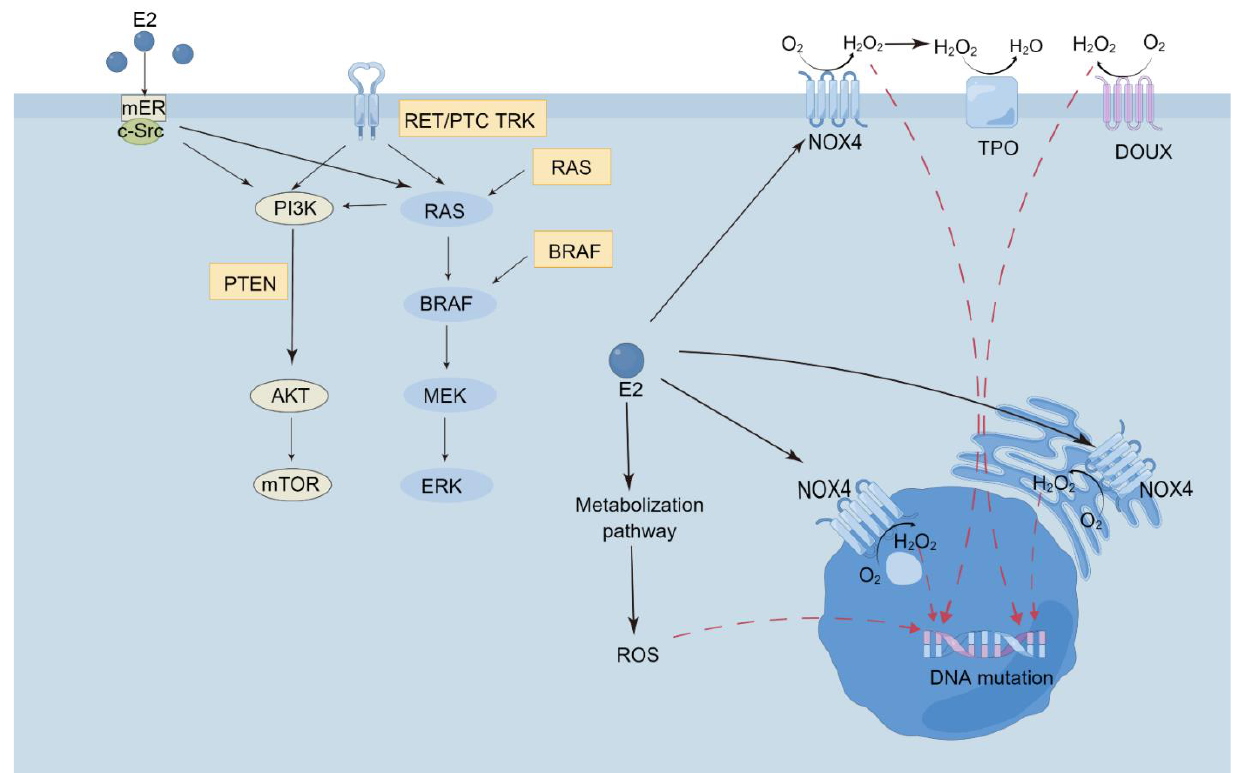
Figure 3. Estrogen non-genomic signaling pathway and estrogen-induced ROS generation in thyrocyte. The non-genomic signaling of E2 occurs via the membrane-bound receptor mER, which stimulates activation of the MAP kinase and the PI3 kinase signaling pathways ( left ). Due to the chromosomal rearrangement of the tyrosine kinase receptor TRKA, PET/PTC genes, BRAF gene, and RAS gene mutation, aberrant activation of the tyrosine kinase pathway occurs. Additionally, the PI3K AKT pathway may also be abnormally activated by mutational inactivation of PTEN. E2 stimulates these pathways [61]. In addition, E2 stimulates NOX4 to product ROS, as well as generates ROS through its own metabolization [65]. NOX4 located in the plasma membrane, endoplasmic reticulum, and nuclear membrane. ROS is able to reach nuclear, then promote some alterations which help thyroid carcinogenesis. DUOX: dual oxidase; E2: estrogen; NOX4: NAPDH oxidase 4; ROS: reactive oxygen species; TPO: